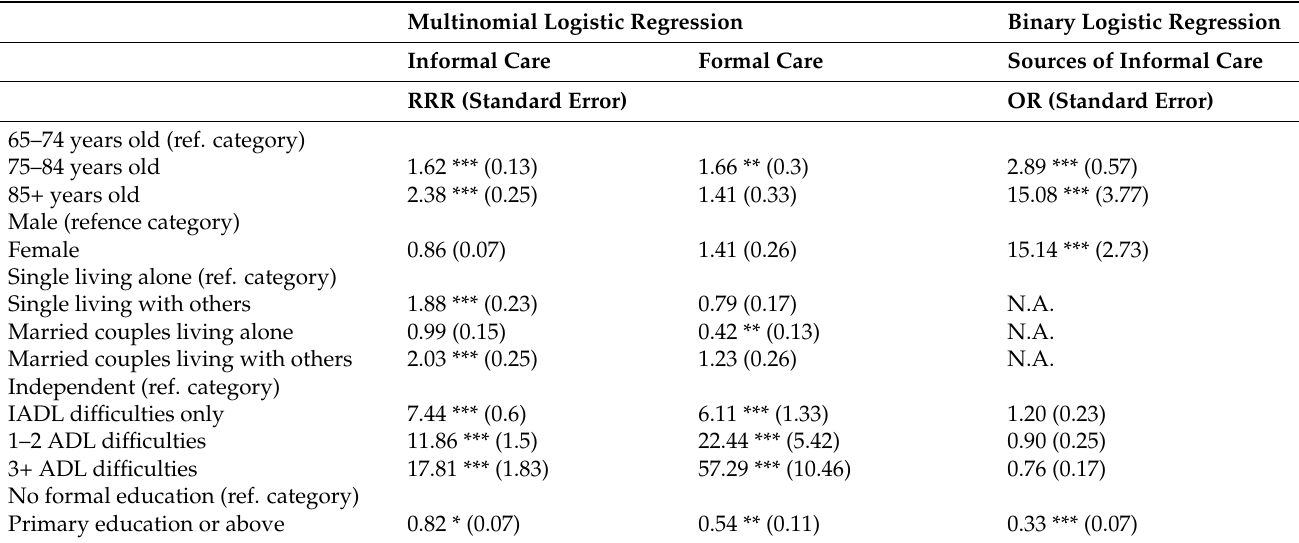
Table 2. Predictors of long-term care receipt and sources of informal care.